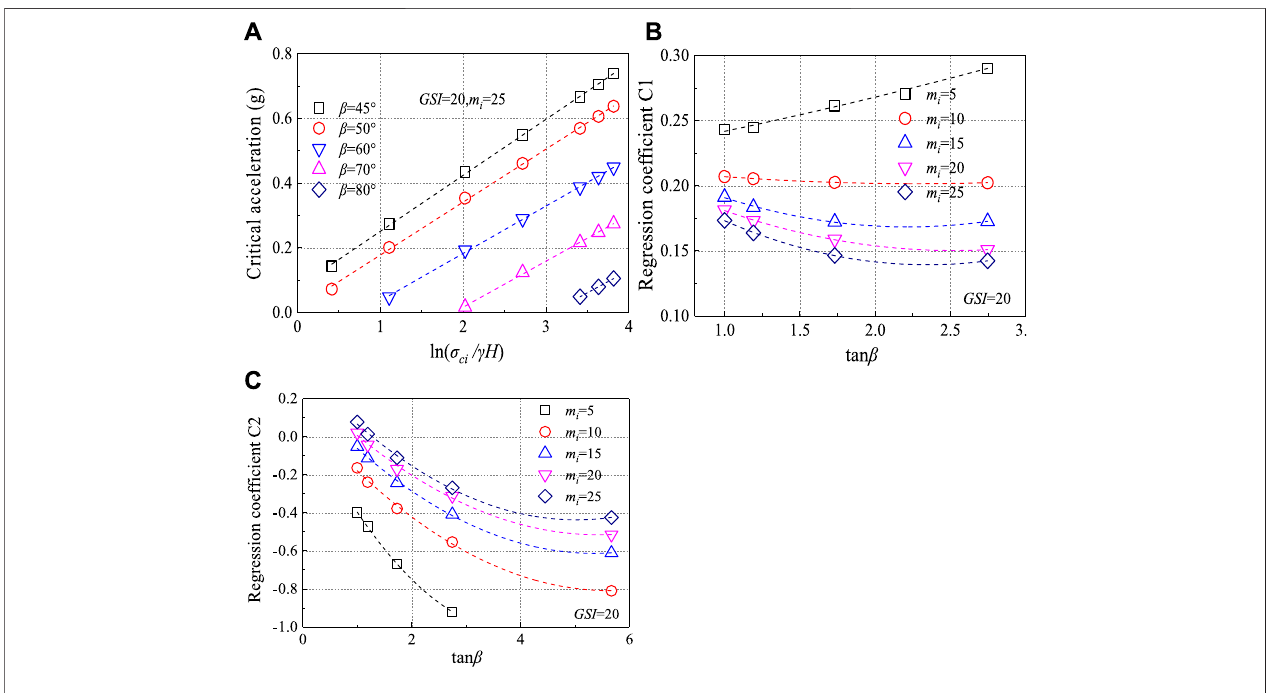
FIGURE 5 | Example of (A) A c versus ln ( σ ci / γ H ), (B) coef fi cient C1 and (C) coef fi cient C2 for GSI = 20 and m i = 25.